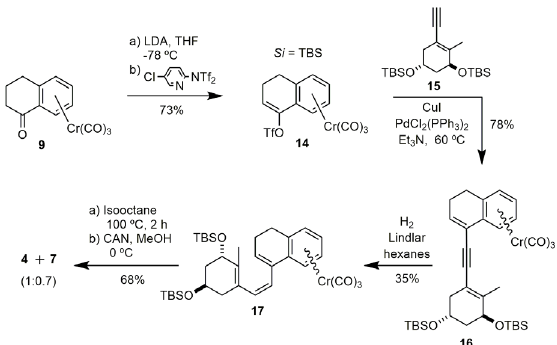
-complexation on the sigmatropic 3